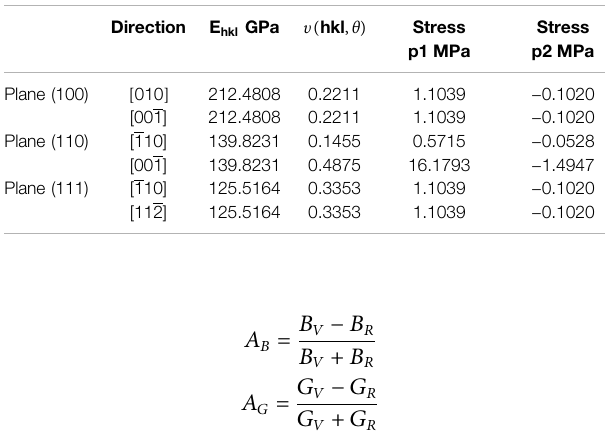
TABLE 4 | Young ’ s modulus in the normal direction of the three low index planes (100), (110), (111) and Poisson ’ s ratio can be calculated for the three lower index planes in directions ( hkl ) in orthogonal